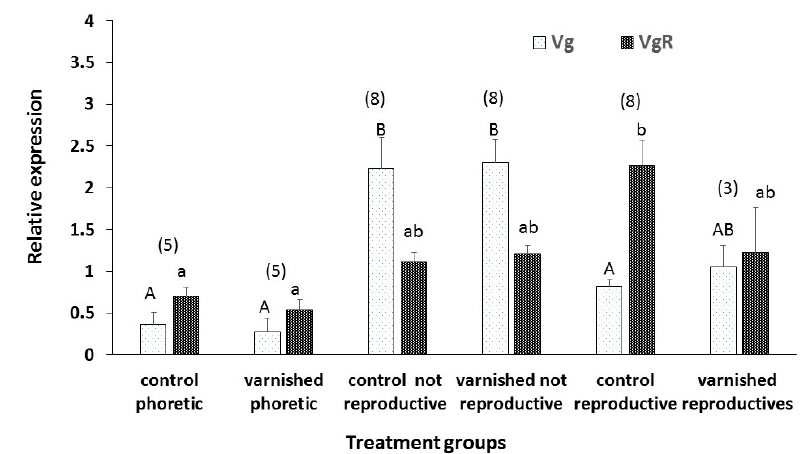
Figure 6. Relative expression of vitellogenin (Vg) and vitellogenin receptor (VgR) in phoretic mites with varnished and unvarnished forelegs as well as four groups of mites collected from worker brood cells after 72 h of infestation: control and varnished mites that were alive but not reproduced and control and varnished mites that had laid an egg. Bars indicate mean ± s.e. Numbers above bars in brackets indicate the number of replicates in each treatment used in RT-qPCR analysis. Different letters above bars indicate treatments that differ significantly, within each transcript, when compared using ANOVA, followed by Tukey HSD, p < 0.05.